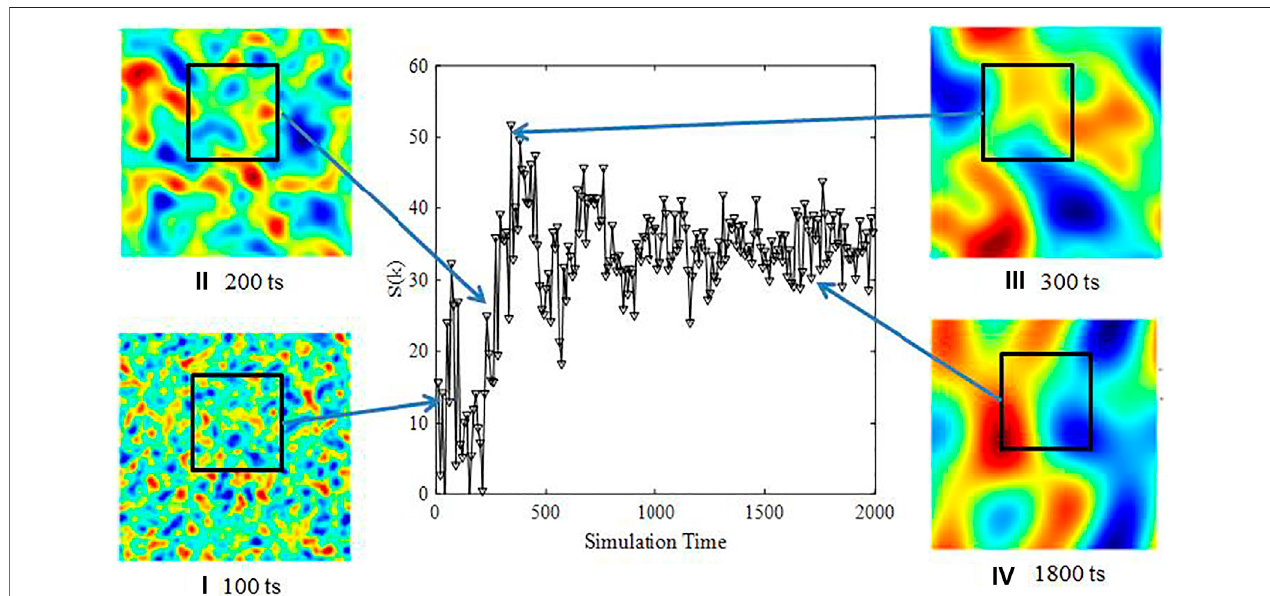
FIGURE5| Temporalevolution of mean structurefactorsover entire domain in thephaseseparation system with interactivestrengthsof G (cid:2) − 30atfour times: (A) 100 ts, (B) 200 ts, (C) 300 ts, and (D) 1800 ts.